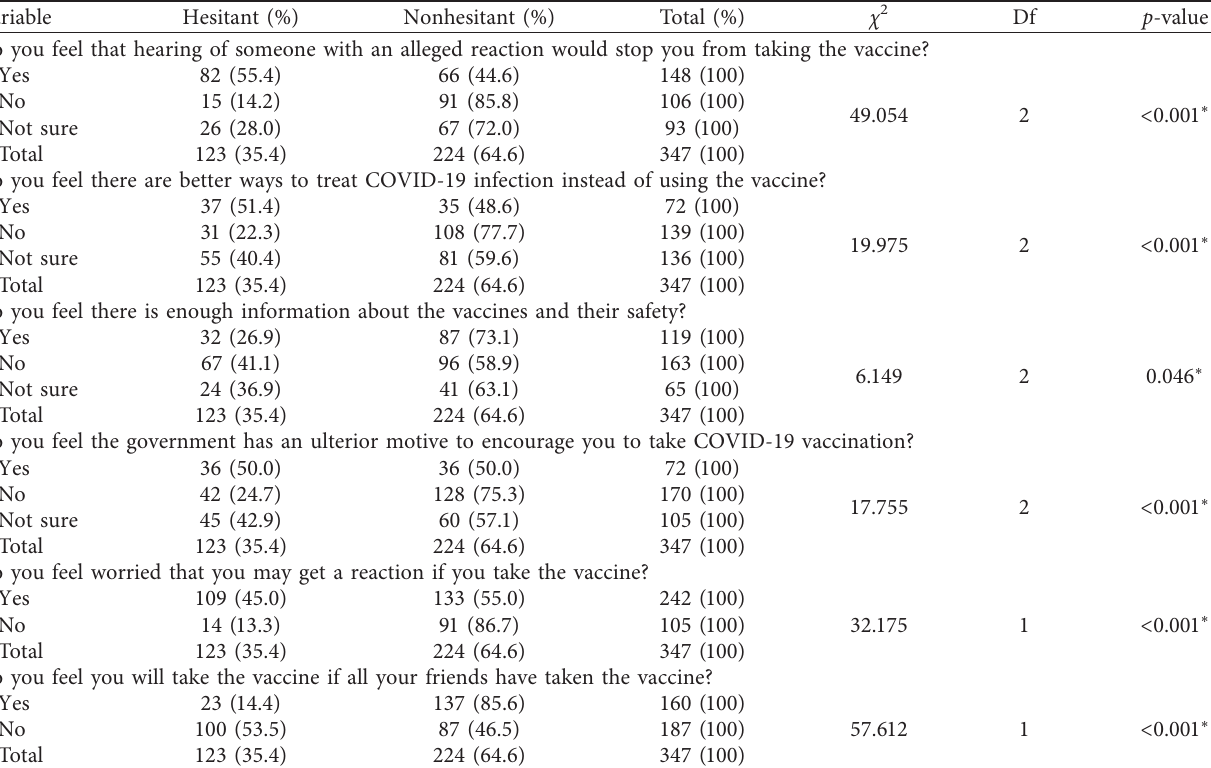
Table 4: Individual perception factors and vaccine hesitancy among HCWs in Imo State,